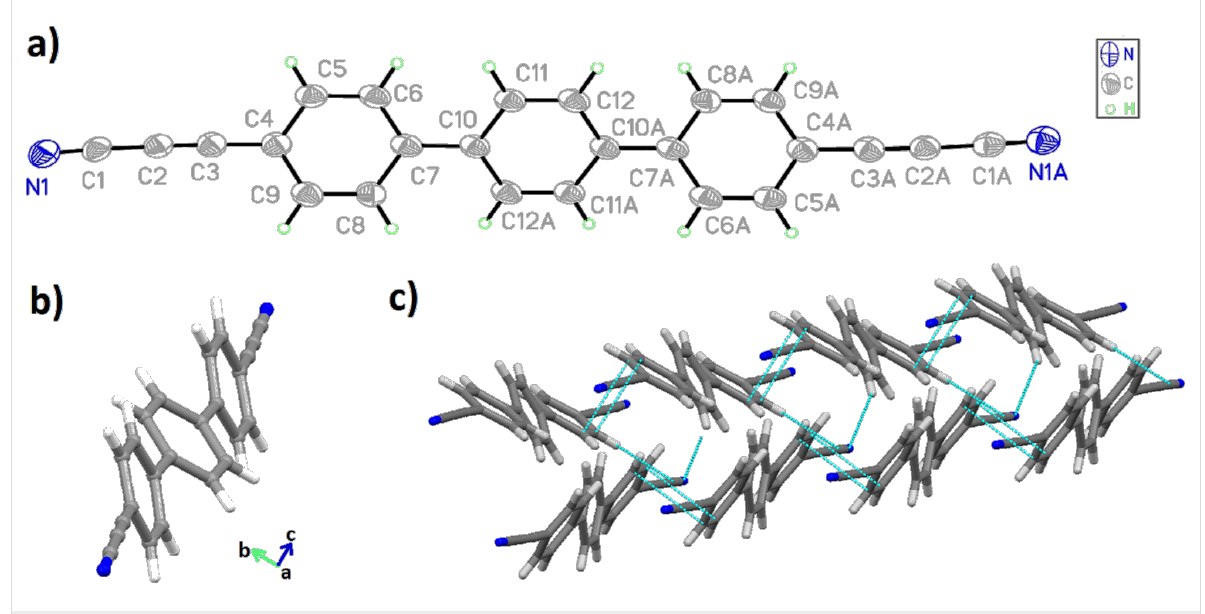
Figure 2: ORTEP plot of compound 2 . Ellipsoids were drawn at a 30% level of probability for all non-hydrogen atoms, indicating the numbering scheme (a); 3D visualization of the molecular conformation (view along direction a ) (b); and the packing viewed along the b* axis demonstrating the parallel layers arrangement (c) .